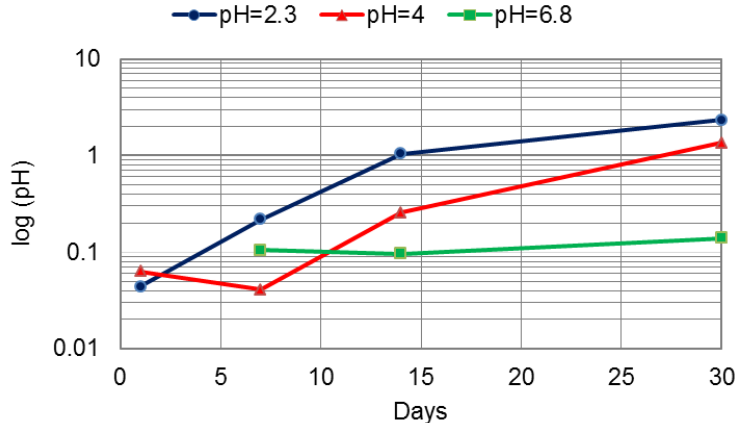
Figure 7. The difference between the release of Mo from the CM and DMLS alloys (μg per cm 2 ) in artificial saliva of pH = 2.3, pH = 4 and pH =